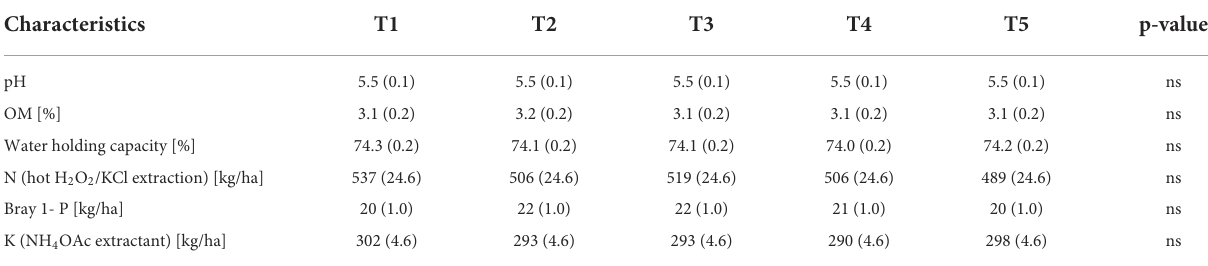
treatments in LR2018 and LR2019 were similar, DM grain and DM residue yields were compared between the two seasons. The DM grain and DM residue yield however increased from LR2018 to LR2019. For instance, treatments T4 and T5 showed the highest grain yield increase of 46.3 and 42.6%, respectively from LR2018 to LR2019. T1 had the lowest grain yield increase of 24.2 %, whereas, in T2 and T3, the yield increase amounted to 29.0 and 25.9 %, respectively from LR2018 to LR2019 (Table 6). The crop residue yield increased by 25.2, 36.4, 36.9, 45.0, and 46.1% for T1, T2, T5, T4, and T3, respectively from LR2018 to LR2019 (Table